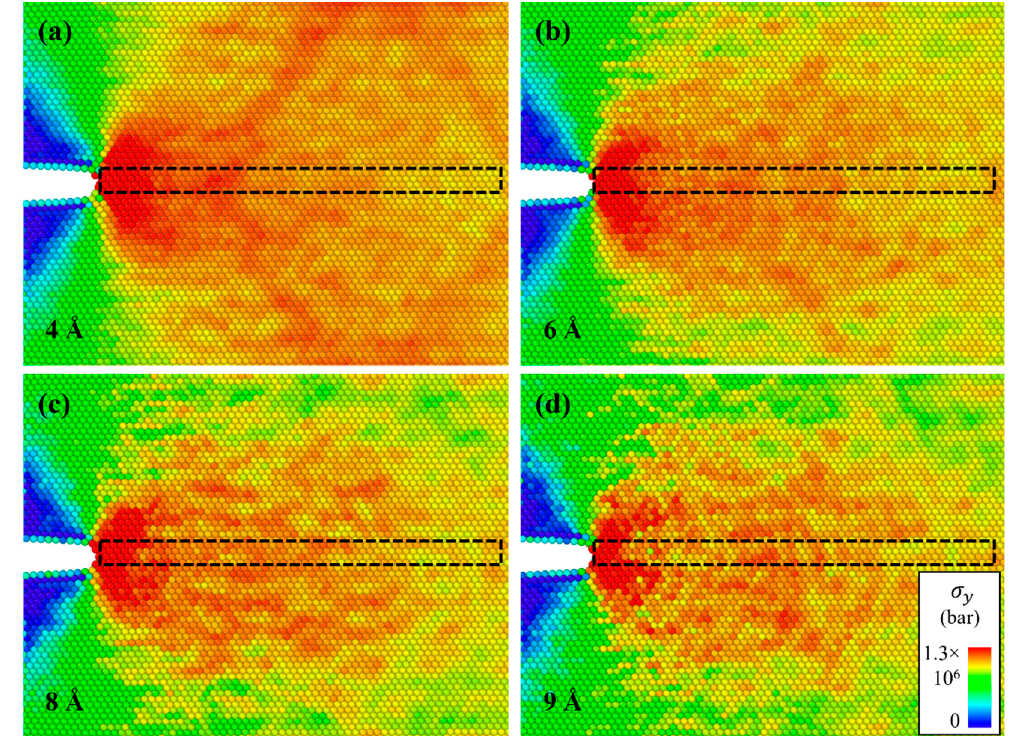
Figure 7. Atomic configurations of the cracked Al containing an Mg – Si cluster with a radius of ( a ) 4, ( b ) 6, ( c ) 8, and ( d ) 9 Å. The configurations were snapshots of their crack-opening strains. The different colors represent the y-axis normal stress in the tensile loading condition. The black dotted box represents the atoms along the crack propagation lines (in this case, parallel to the x-axis). The quantitative stress of the atoms in the marked box is shown in Figure 8.